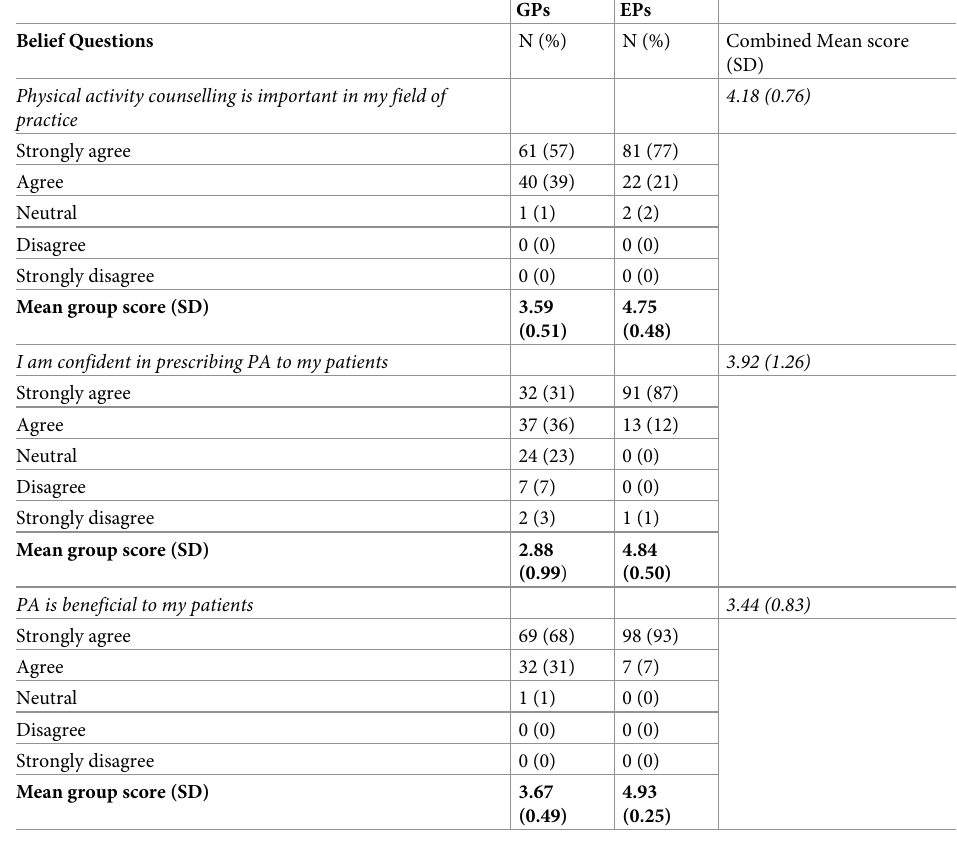
Mann-Whitney U test was calculated for all the total scores for the belief questions to deter- mine the difference in the levels of belief between GPs and EPs. The results indicated that EPs Table 4. Participants’ PA and PARS beliefs (N =